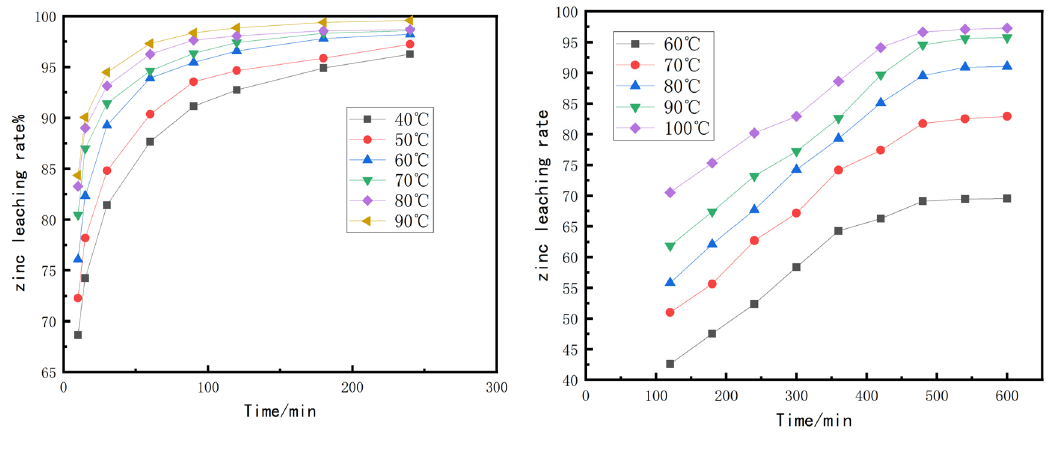
Figure 8. Influence of the temperature on the zinc leaching rat ( a ) conventional: liquid ‐ solid ratio = 16:1, stirring speed = 400 rpm; ( b ) ultrasonic: liquid ‐ solid ratio = 15:1, ultrasonic power = 450 W.